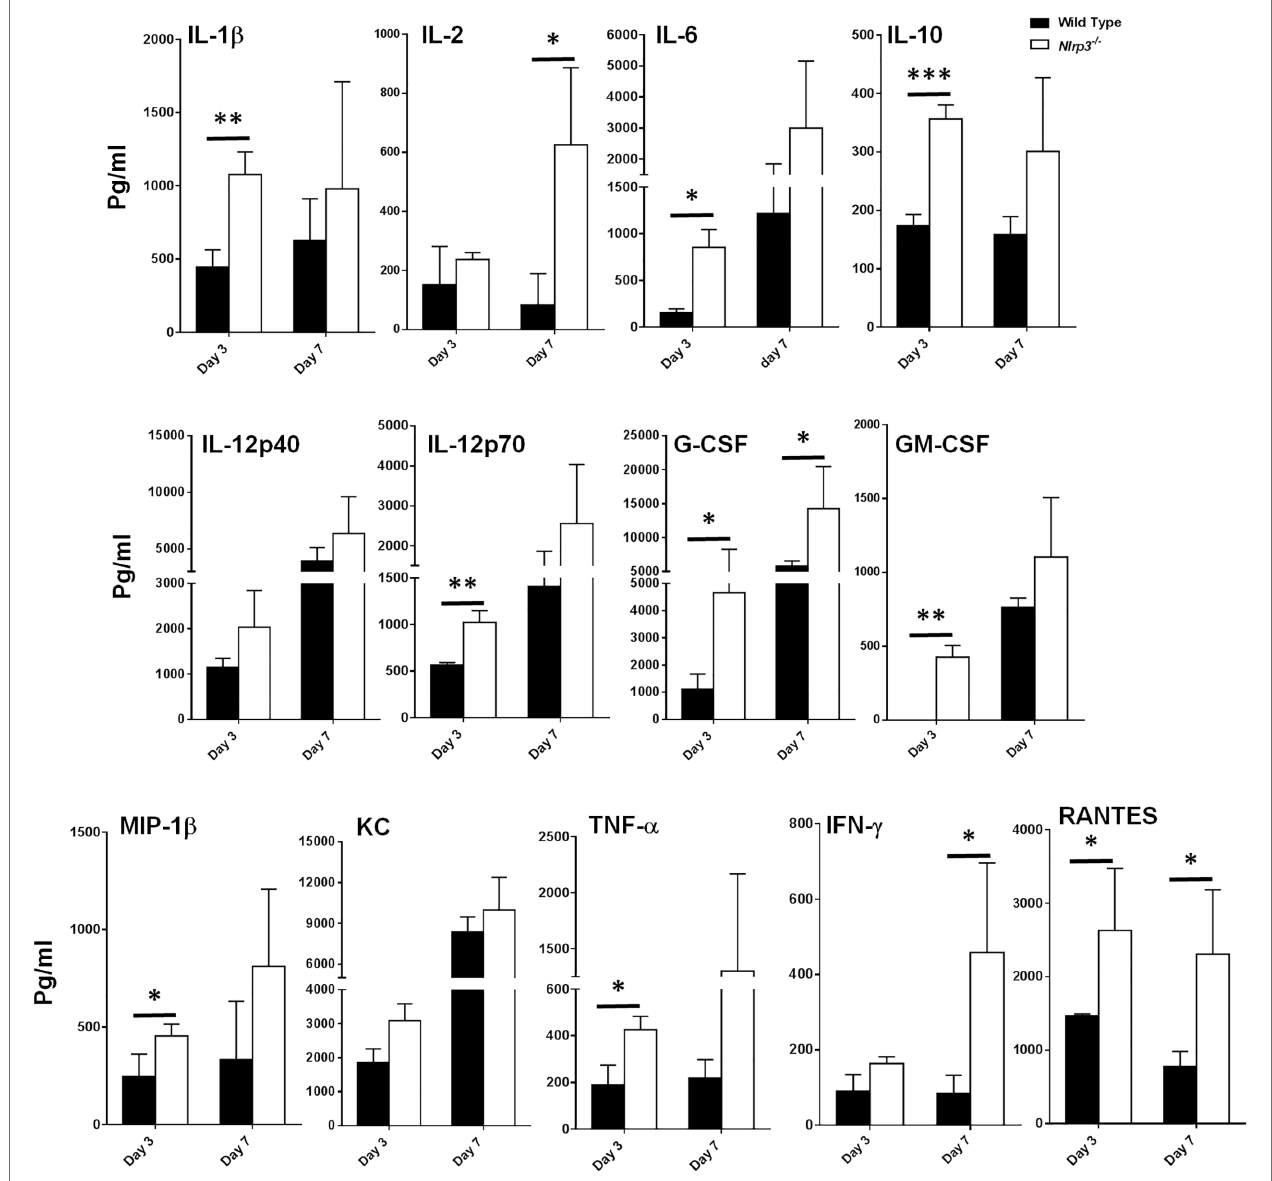
FIGURE 4 | Nlrp3 − / − mice exhibit enhanced production of cytokines and chemokines as compared to the wild type mice. C57BL/6 wild-type and Nlrp3 − / − mice infected intranasally with 1 × 10 4 CFUs of F. tularensis LVS were euthanized on days 3 and 7 post-infection and their lungs were homogenized. The clarified homogenates were used for quantitation of cytokines and chemokines using multiplex cytokine bead array. The cytokine levels are expressed as picogram/ml and are cumulative of two independent experiments, each conducted with n = 3 mice/group/time point (Total n = 6/group/time point). The data were analyzed by unpaired t -test and a value of p of 0.05 or less was considered significant. * p < 0.05; ** p < 0.01; *** p <